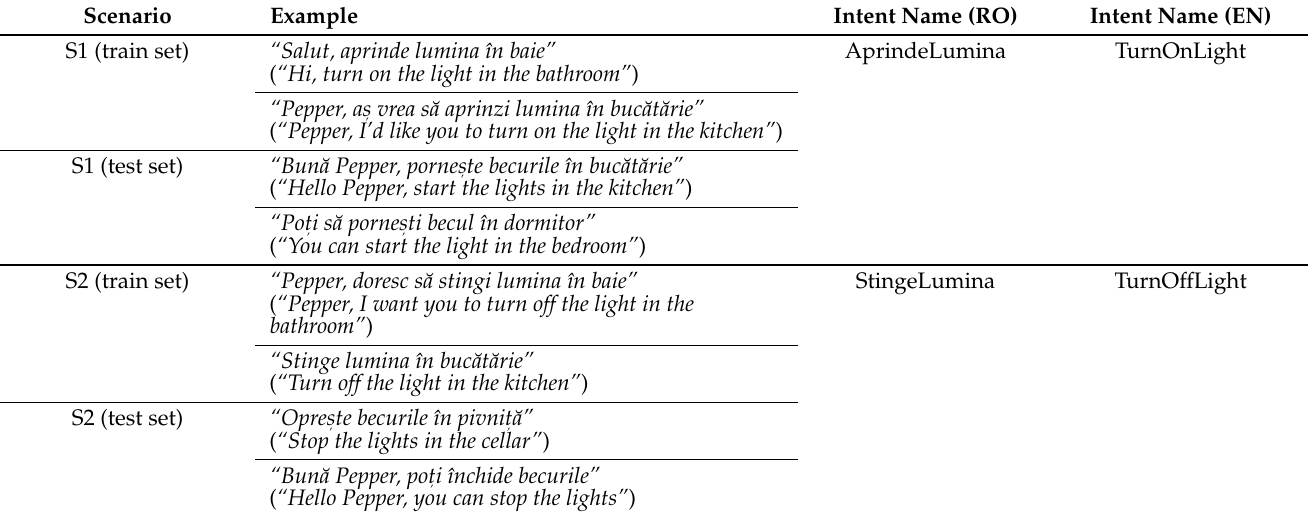
Table A2. Sentence examples and their